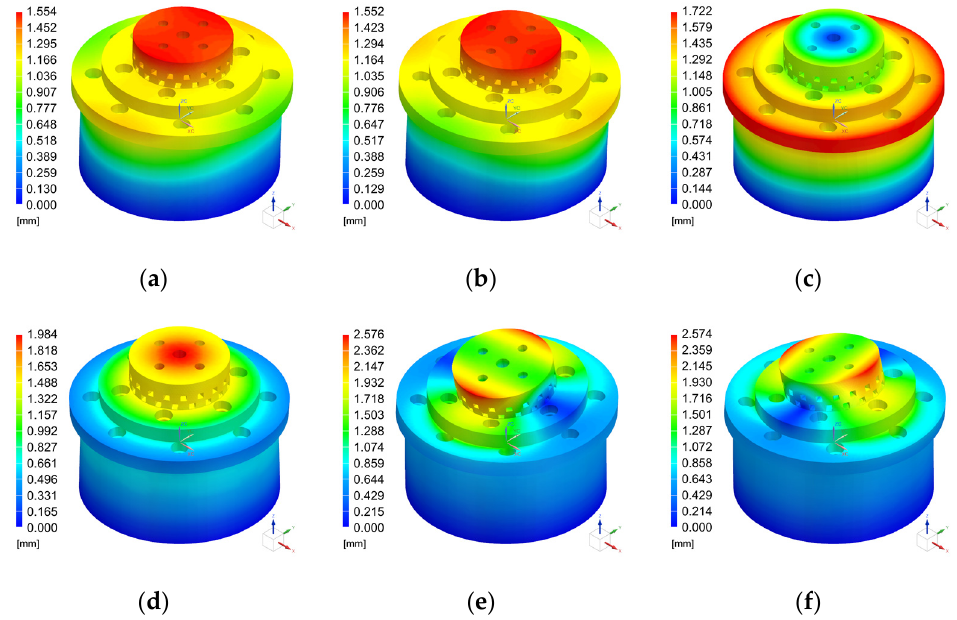
Figure 8. The deformation contour of the first six modes of the model. ( a – f ) Mode 1–6, and their natural frequencies are 5655.9, 5659.82, 10,474.1, 11,072.5, 14,147.6, and 14,155.0 Hz, respectively.